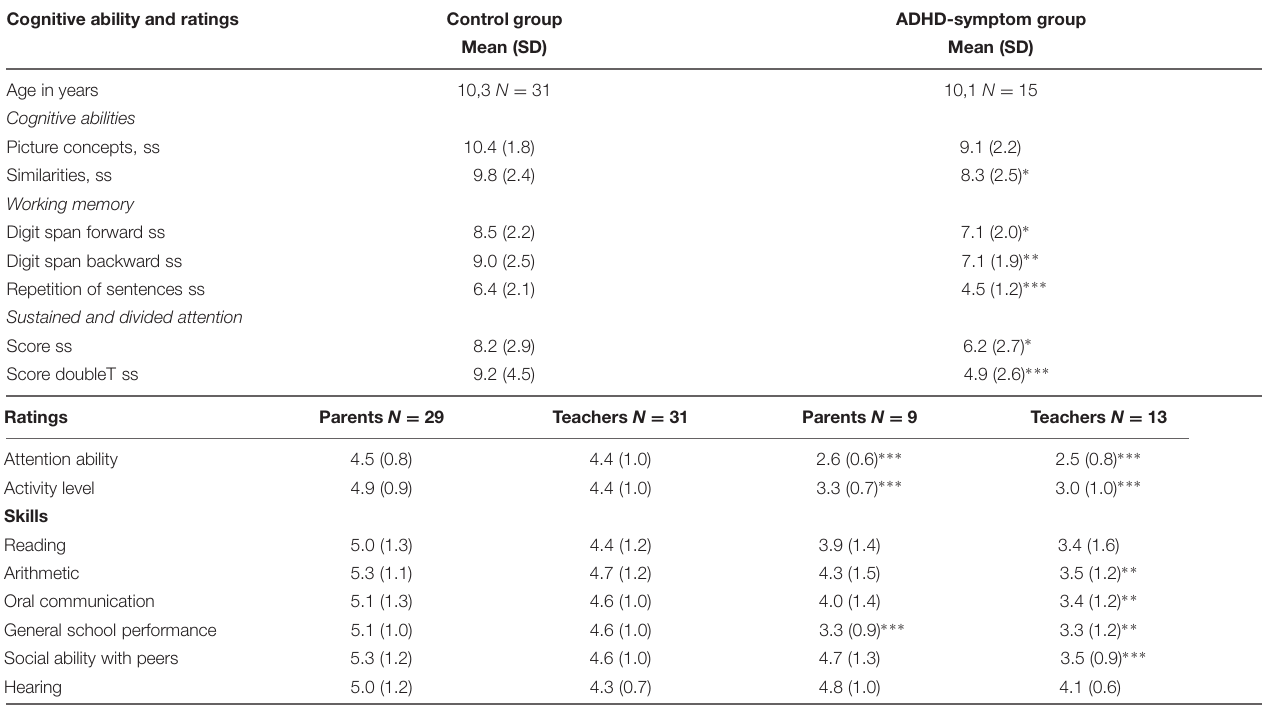
TABLE 1 | Participant characteristics: cognitive test scores and